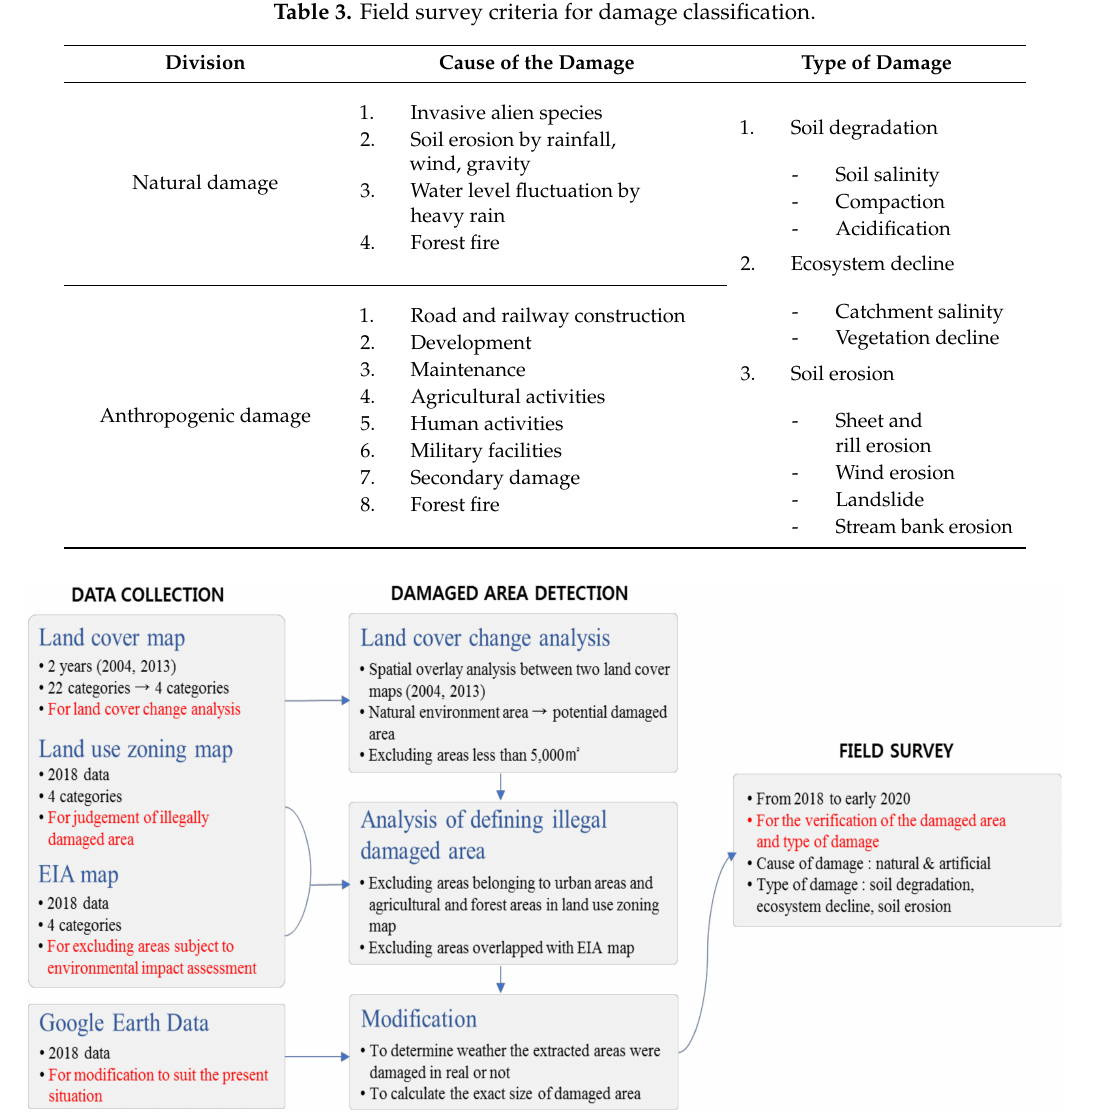
Figure 4. Utilization data and analysis flow chart for detecting ecological damaged